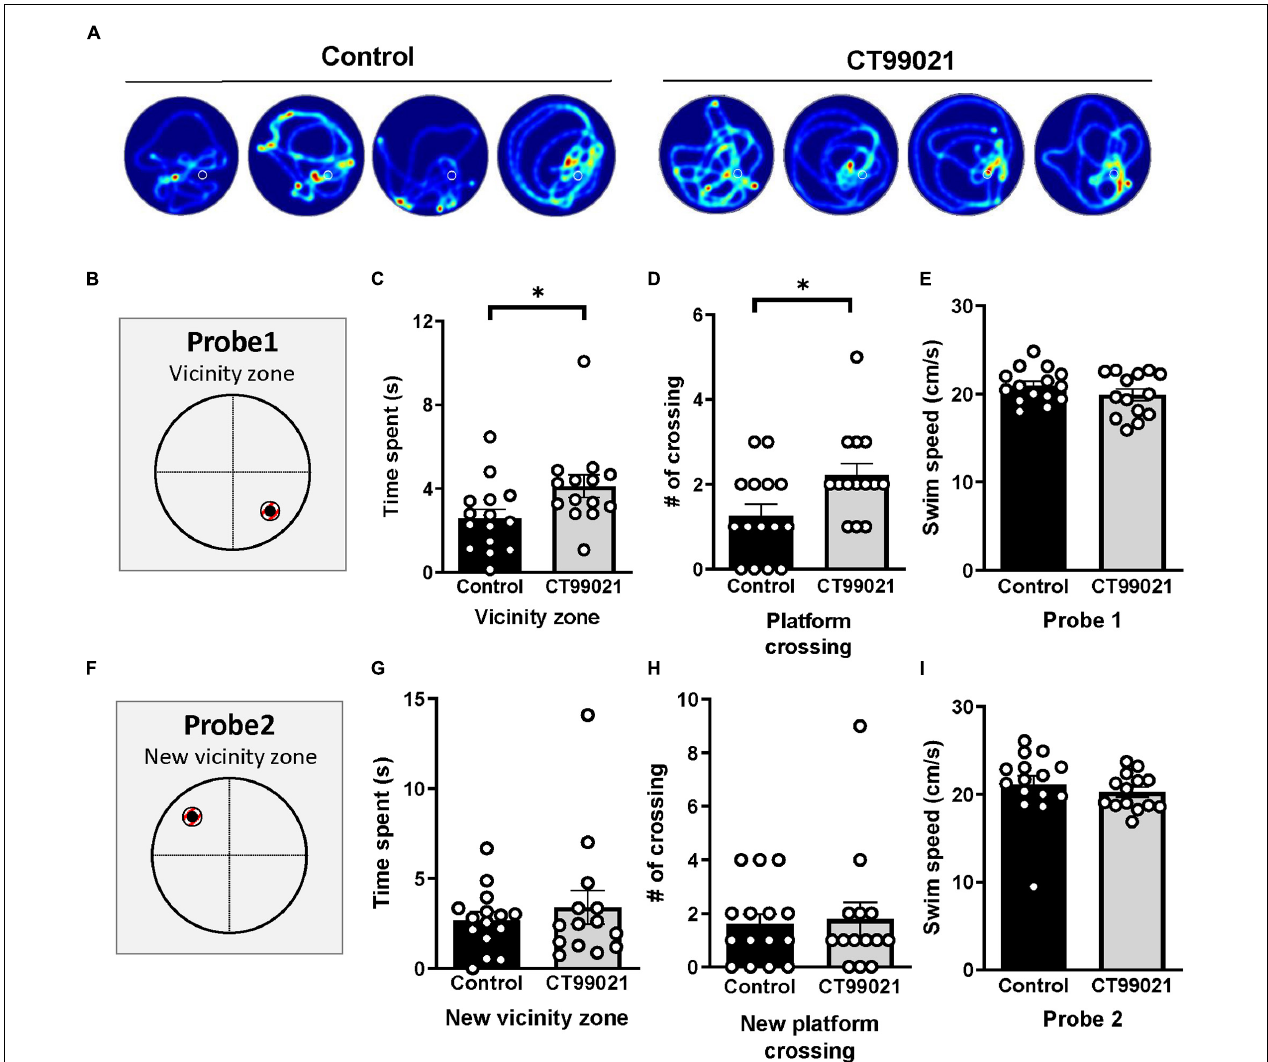
FIGURE 5 | CT99021 improves accuracy of spatial memory. (A) Four sample heat map traces on probe 1 from each group are shown. The white circle represents where the hidden platform was placed. (B) (Left) Illustration of the vicinity zone for the probe 1 test. (C) The CT99021 group showed increased time spent in the vicinity zone ( ∗ p < 0.05, unpaired t -test). (D) Increased number of platform crossings by the CT99021 group ( ∗ p < 0.05, unpaired t -test). (E) Swim speed on probe 1 is indistinguishable between the two groups ( p > 0.05, unpaired t -test). (F) The new vicinity zone on the probe 2 trial. (G) Time spent in the new vicinity zone is comparable between two groups ( p > 0.05, unpaired t -test). (H) The numbers of platform crossings are similar ( p > 0.05, unpaired t -test). (I) Swim speed is also comparable on probe 2 ( p > 0.05, unpaired t -test). Control: vehicle group (black histograms), CT99021: drug treatment group (gray histograms). Data are presented as mean ±